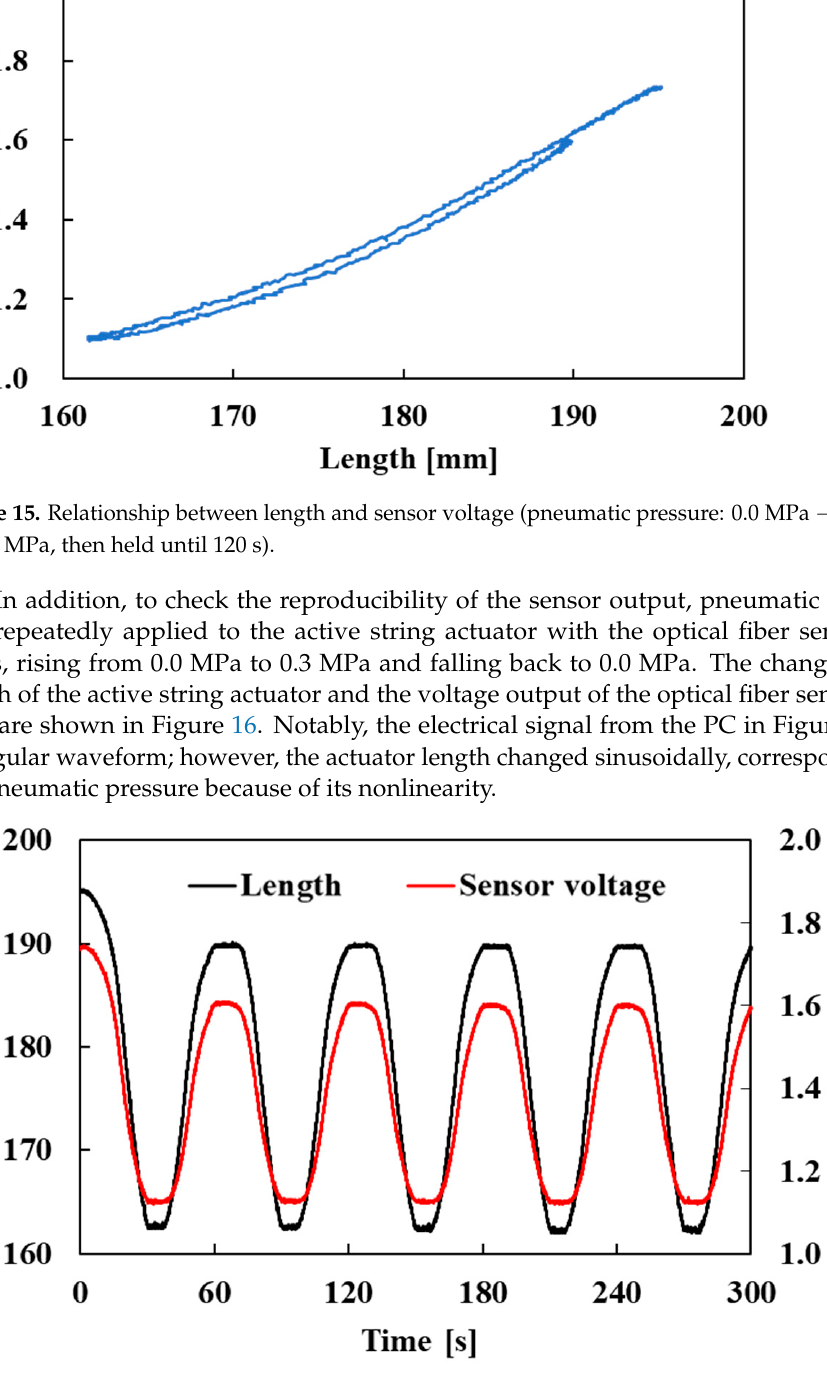
Figure 16. Length and sensor voltage variation with respect to time (pneumatic pressure: 0.0 MPa → 0.3 MPa → 0.0 MPa, five times). The relationship between the length of the active string actuator and voltage output of the optical fiber sensor is shown in Figure 17. The relationship between the active string length and the sensor voltage followed the same route, so we consider the sensor output to be highly reproducible.